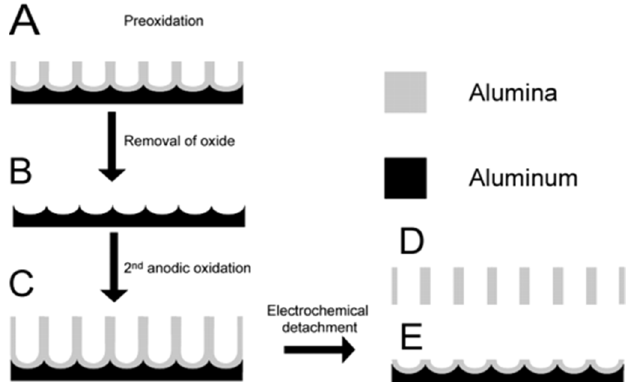
Figure 11. Schematic representation of the fabrication procedure for the formation of ordered and through-hole porous alumina membrane. ( A ) Formation of the porous alumina layer after the first anodic oxidation process; ( B ) removal of the porous alumina layer; ( C ) formation of the ordered porous alumina layer after the second anodic oxidation process; ( D ) free-standing porous anodic alumina (PAA); ( E ) the barrier layer structure on aluminum base after electrical detachment of the PAA. Reprinted with permission from reference [127]. Copyright 2004 American Chemical Society.